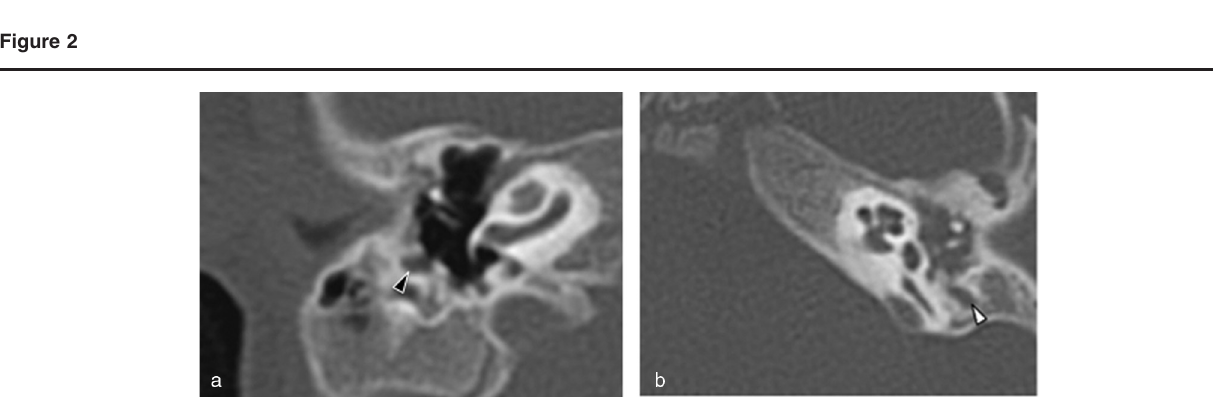
A: Indicate type 2 (normal mastoid with black arrow point to sentinel air cell). B: Indicate type 2 (mastoid with OME arrow point to sentinel air